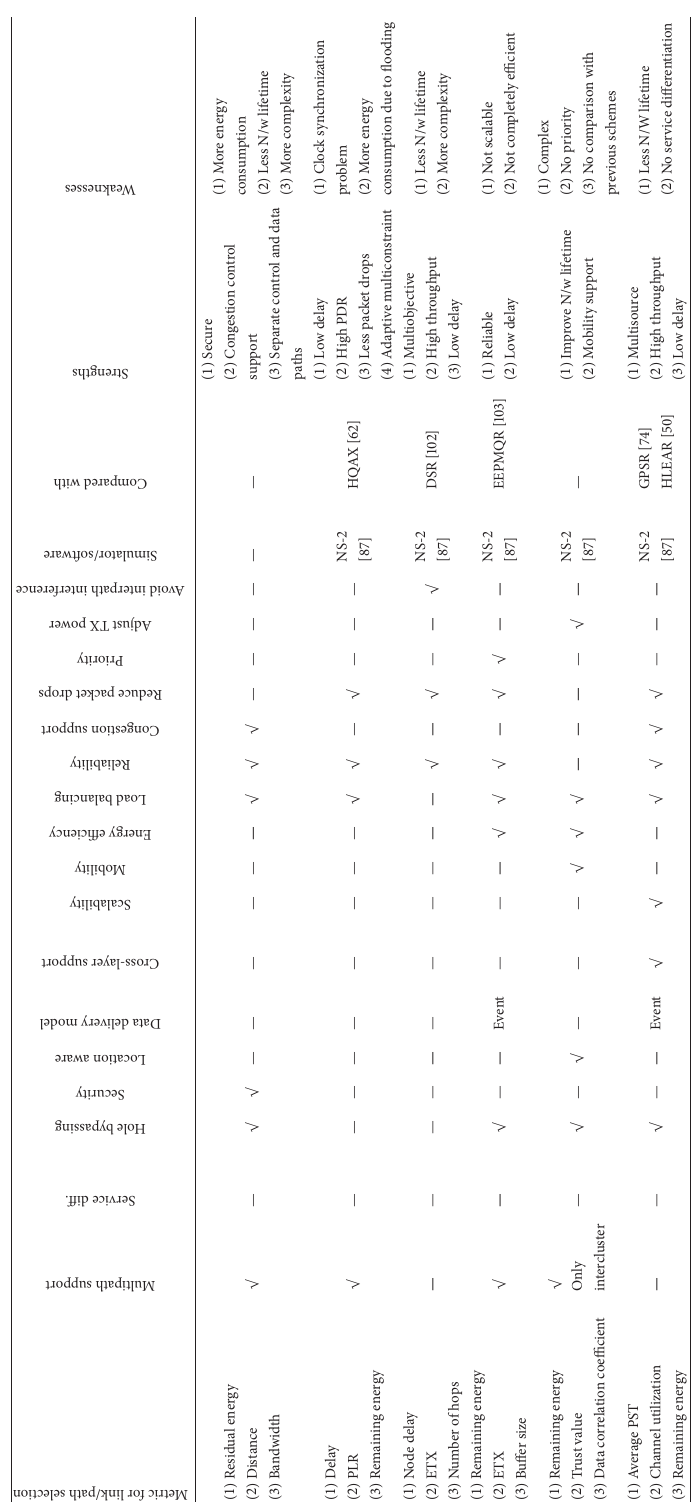
Metricforlink/pathselection